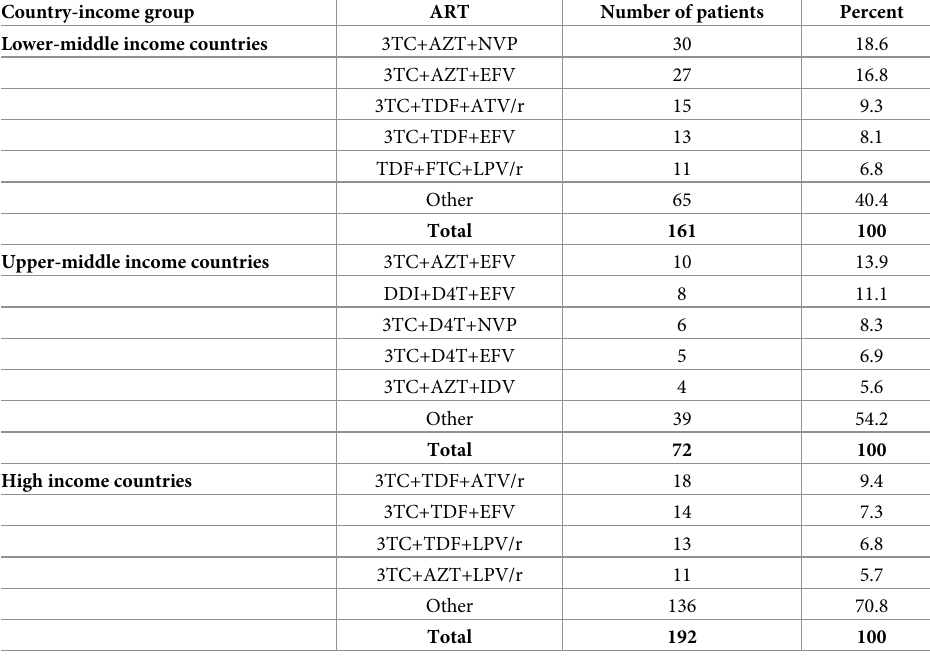
Table 2. Patterns of holding regimens by World Bank country-income level. Country-income